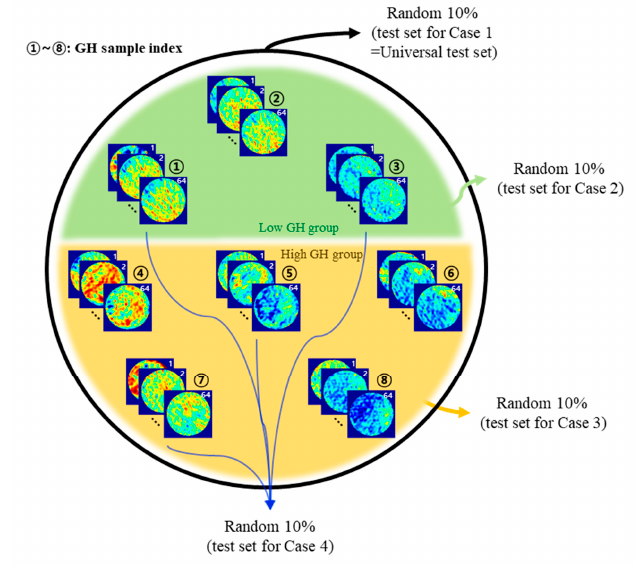
Figure 8. Two test sets: random 10% test from each of the four cases and universal test set from the eight GH samples. Table 3. Conditions and settings for Cases 1–4 with random forest.